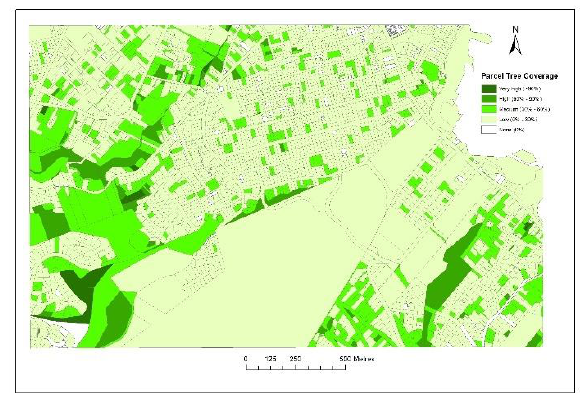
Figure 11. Classified urban trees coverage per-parcel map of study area.